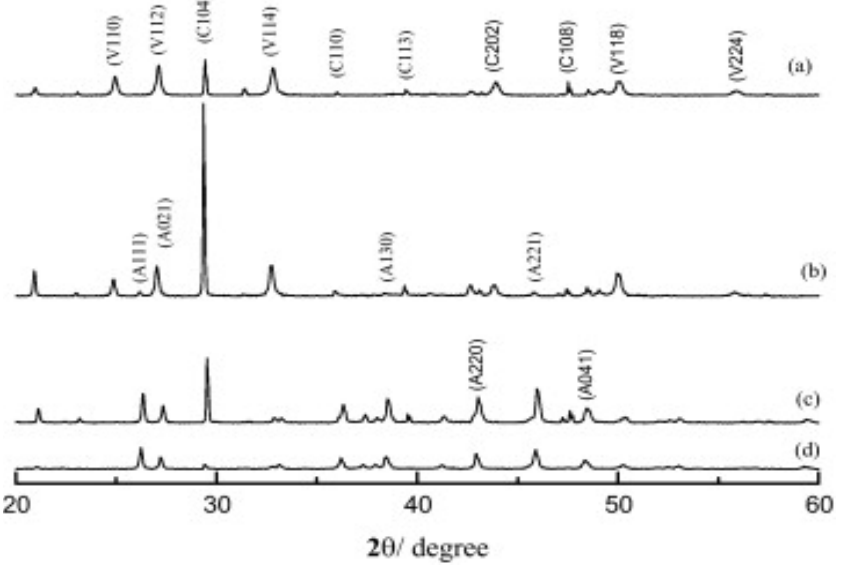
Figure 10. XRD patterns of the samples obtained at different temperatures: ( a ) 28 ◦ C, ( b ) 40 ◦ C, ( c ) 70 ◦ C, and ( d ) 75 ◦ C. (C: calcite; V: vaterite; A: aragonite). This Figure is adopted with permission from [57].